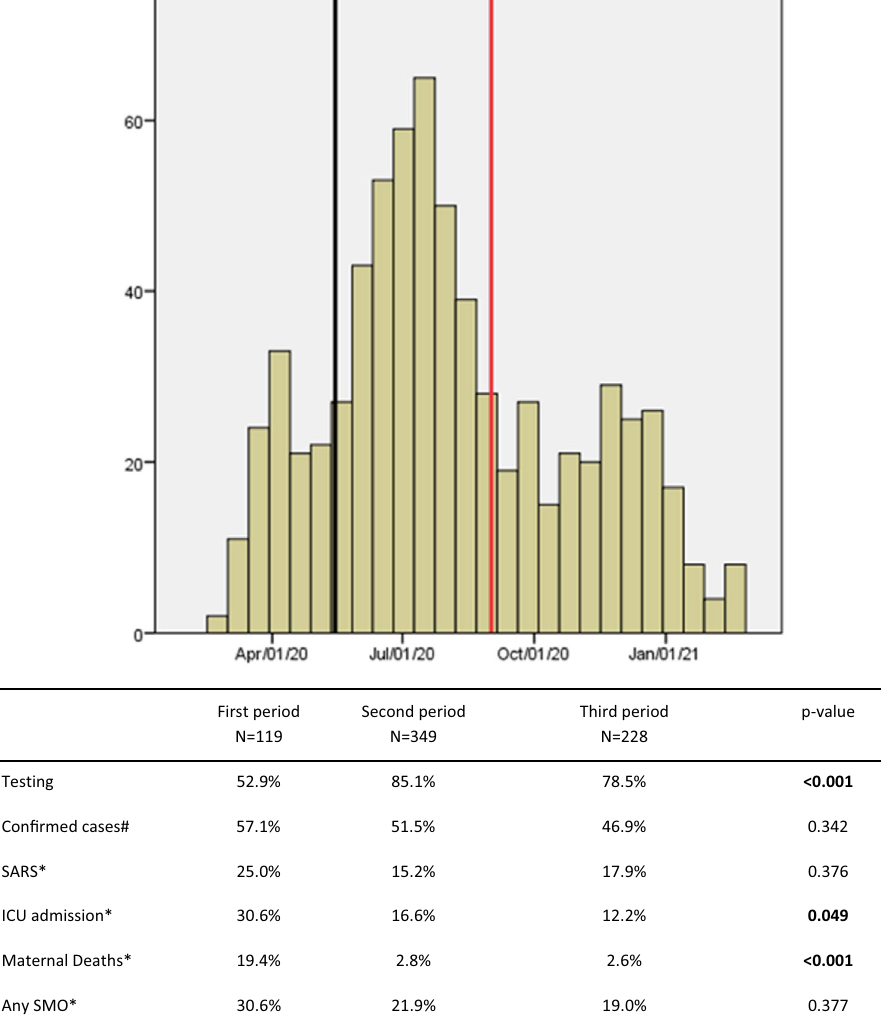
Figure 3. Case series of total included women divided by the three study